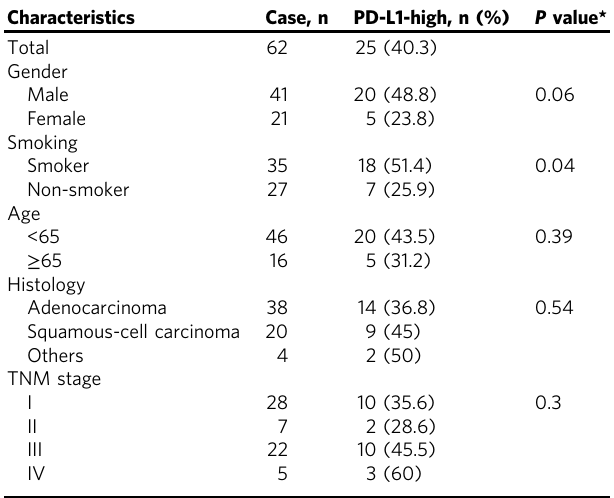
Table 1 Baseline demographic characteristics of the patients Characteristics